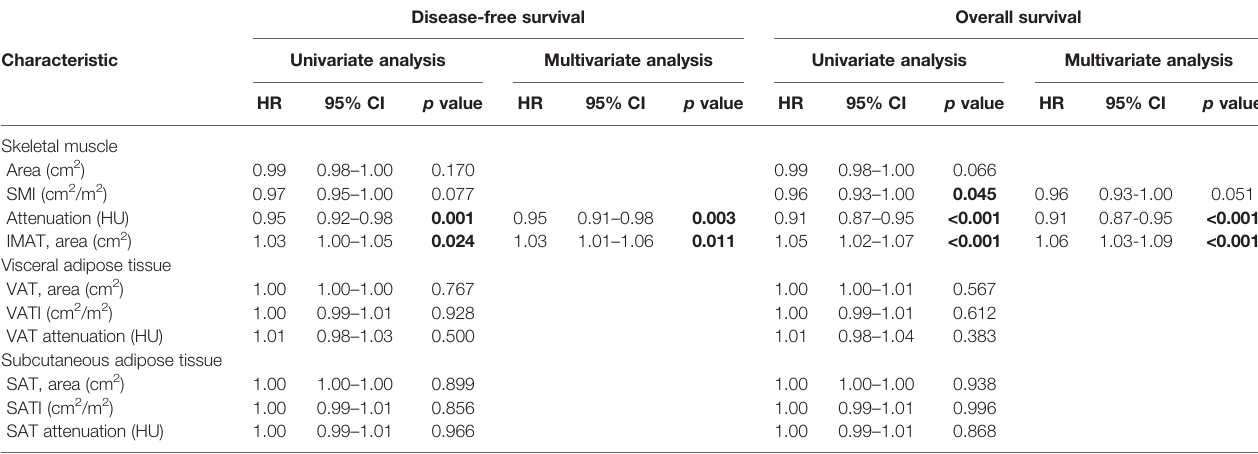
TABLE 2 | Univariate and multivariate COX regression analyses of body composition features of colon cancer patients.